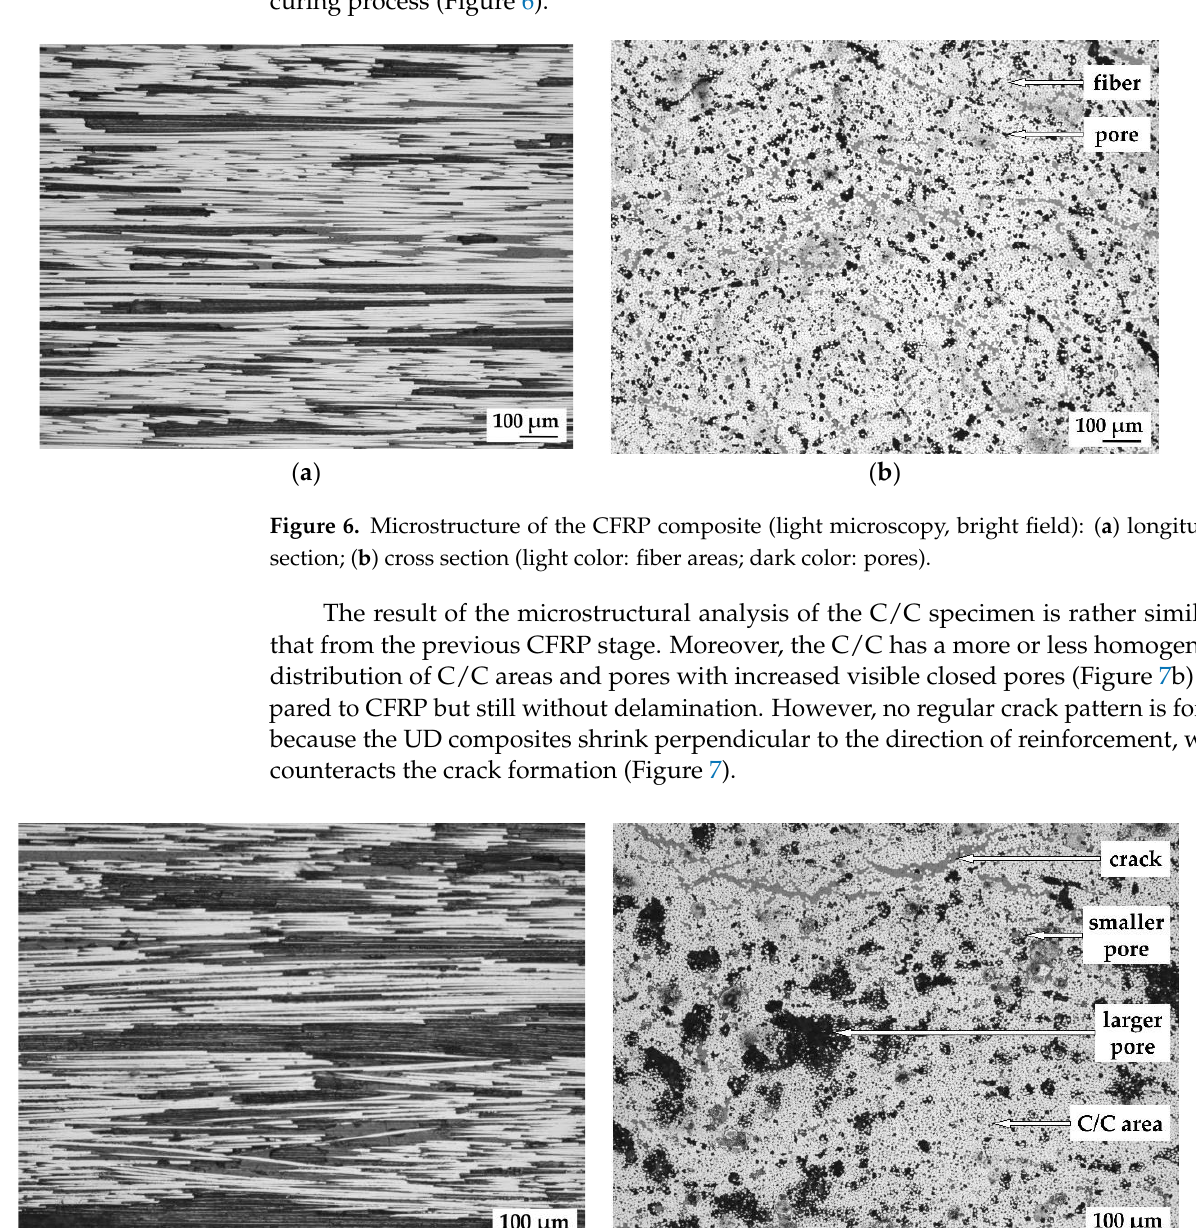
Figure 5. Roughness for different development stages: ( a ) longitudinal direction; ( b ) transversal di- rection. Reference material is glass-fiber-reinforced epoxy from the same tool.